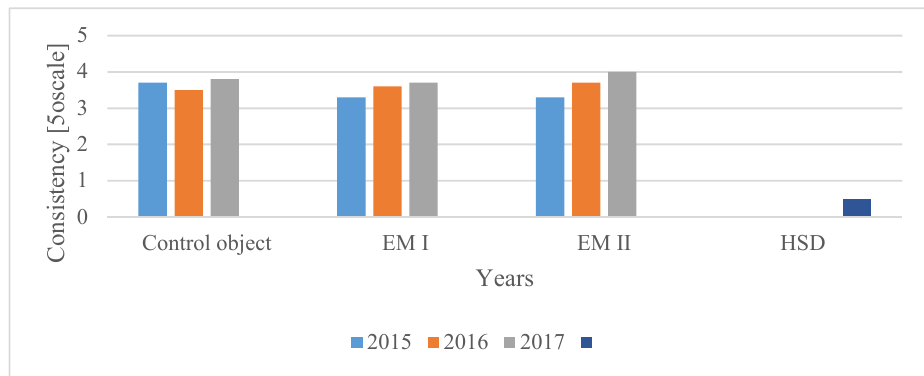
Figure 5. Effect of EM on the consistency of FF over the years of the research. × years (18.1–44.2, average 33.1%), followed by variety (23.7–37.9%, average 32.9%), then